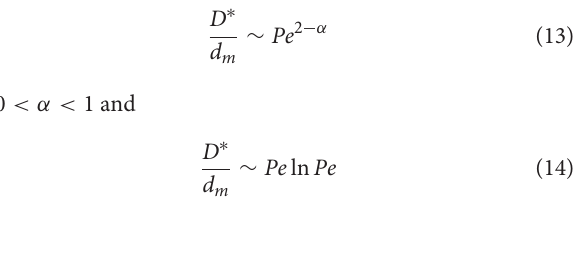
displays a power-law scaling p e ( v ) ∼ v α − 1 for v < h v m i . For flow profile close to the grains (due to the no-slip boundary α ≃ 1 (Dentz et al., 2018). In more heterogeneous porous et al. (2021) found α ≈ 0.35 for a Berea sandstone